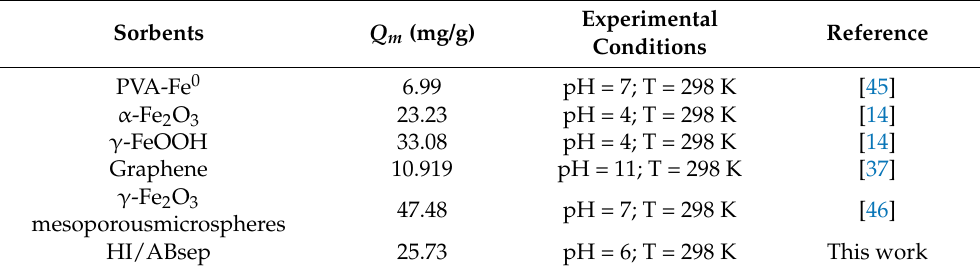
Table 3. Comparison of Sb (III) adsorption by various adsorbents.